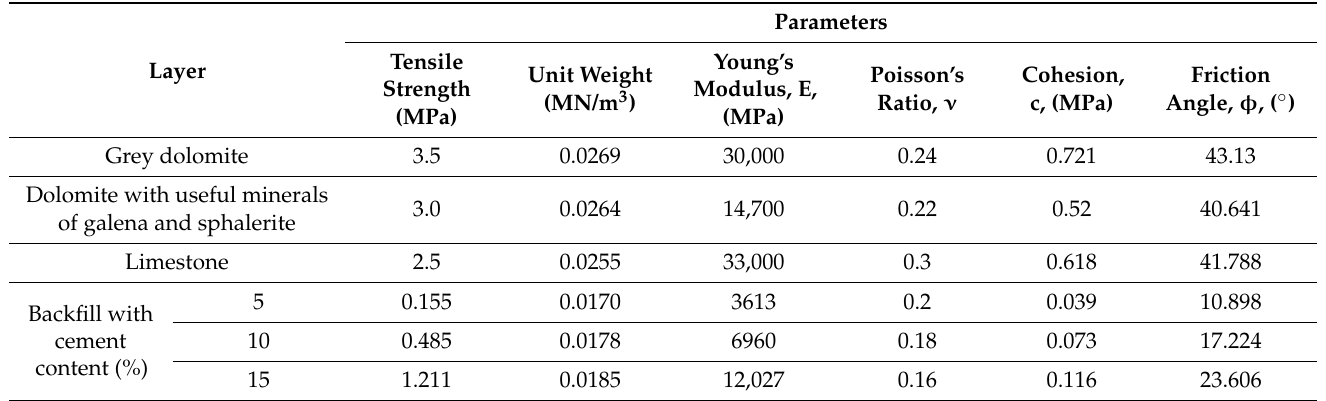
Table 2. Parameters of the rock mass and the cemented paste backfill.